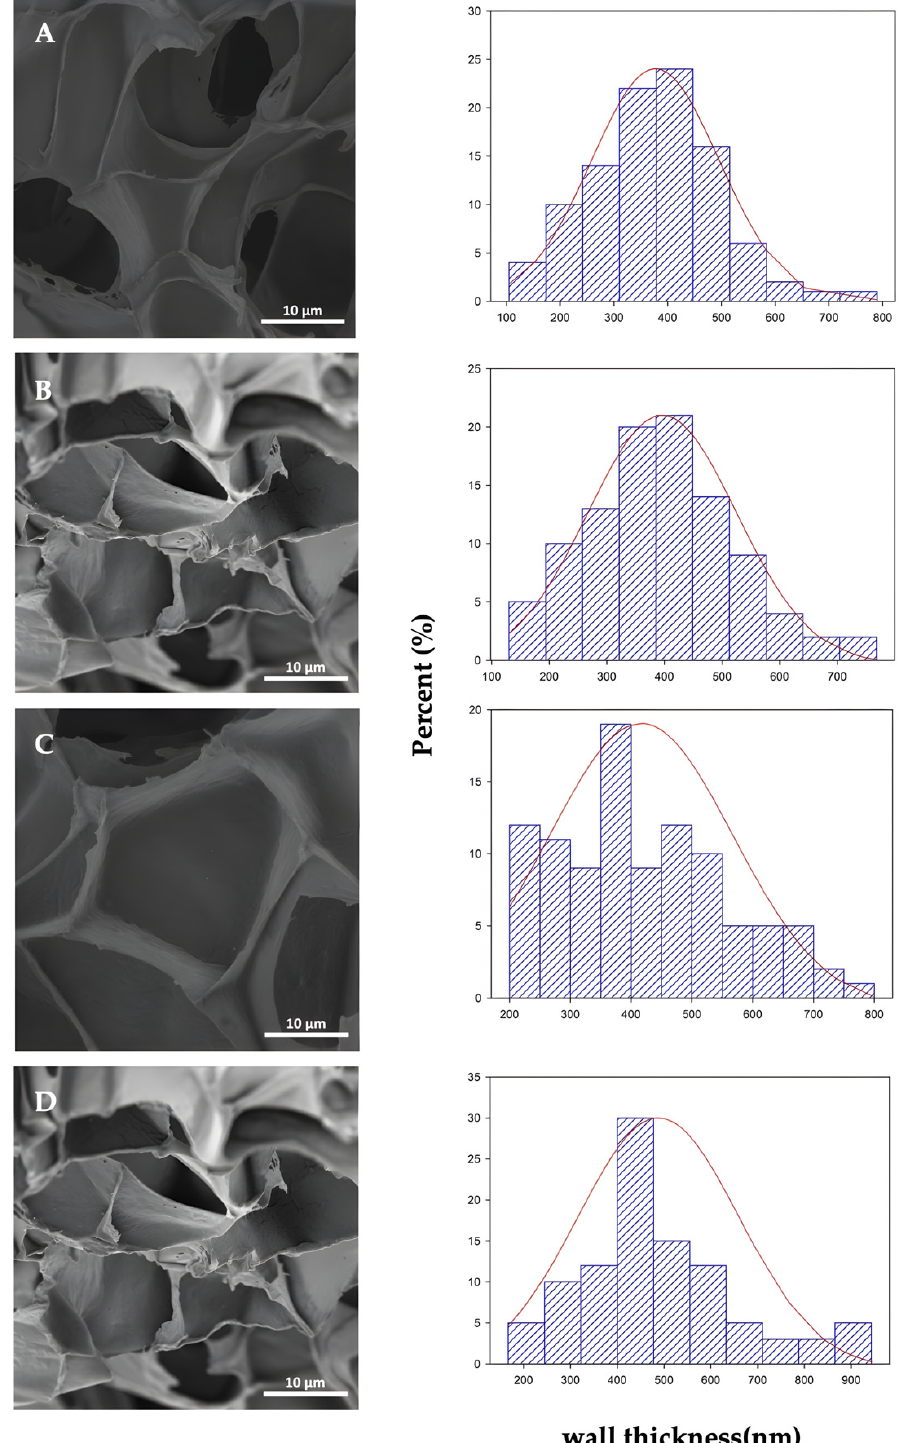
Figure 5. Left side: SEM micrographs of cross-sections of samples cryofractured at 4.0 kx and wall thickness distribution of PLA foam cells. PLA foam samples ( A ) neat PLAf, ( B ) PLAf 1% C30B, ( C ) PLAf 2% C30B, and ( D ) PLAf 3% C30B nanocomposites, reprinted from Rojas et al. [43] under Creative Commons CC BY license. Right side: cell diameter distribution of PLA foams: (A’) neat PLAf, (B’) PLAf 1%C30B, (C’) PLAf 2%C30B and (D’) PLAf 3% C30B nanocomposites.